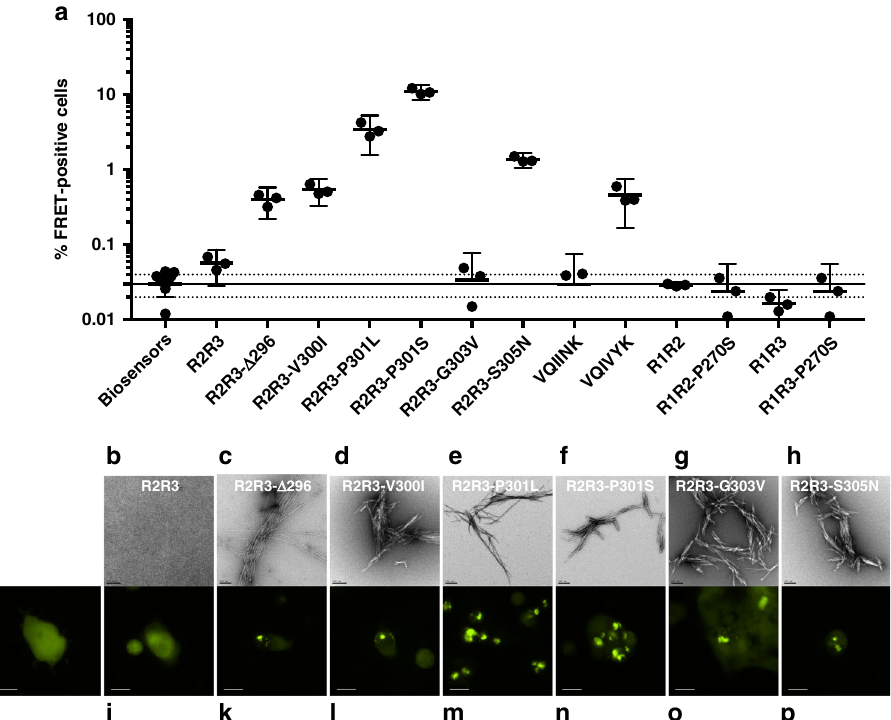
Fig. 5 Peptides form amyloid structures and seed in vivo. a After 96 h of in vitro incubation, peptides from previous ThT experiments (Fig. 4c) were transduced into tau biosensor cells via lipofectamine (Methods). FRET signal from each condition (tau RD-CFP/tau RD-YFP) was measured by fl ow cytometry on three biological triplicates of at least 10,000 cells per condition. Error bars represent a 95% CI of each condition. Solid and dashed horizontal lines represent the mean and 95% error from untreated biosensor cells, respectively, for ease of statistical comparison. b – h Electron microscopy images of each peptide from previous ThT experiments (Fig. 4c). The black bar represents 200 nm distance in each image. i – p Qualitative fl uorescence microscopy images of tau biosensor cells immediately prior to fl ow cytometry experiments. i shows a representative image of untreated biosensor cells . j – p each shows a representative image of biosensor cells treated with samples from b – h , respectively. The white bar represents 10 μ m distance in each image